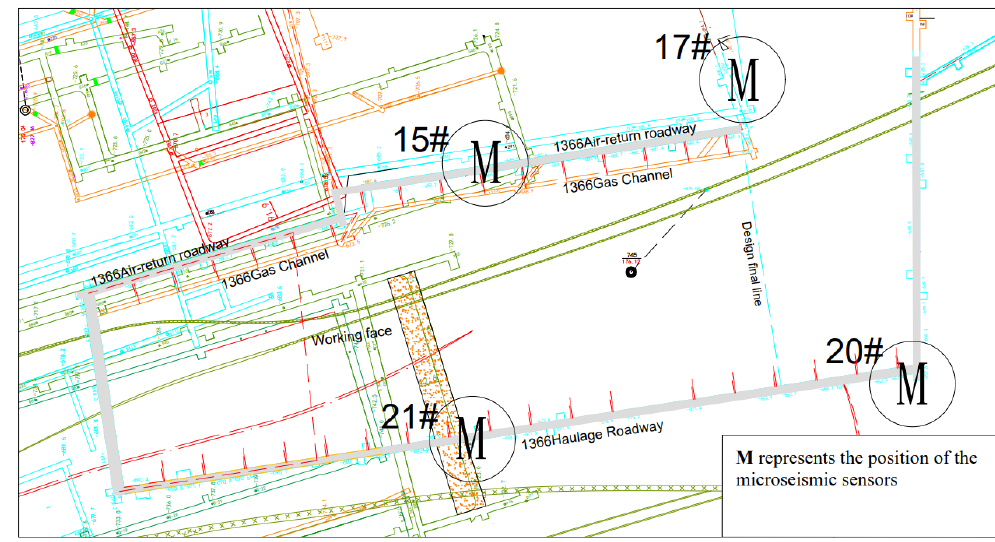
Figure 1. Layout of microseismic sensors in 1366 working face.